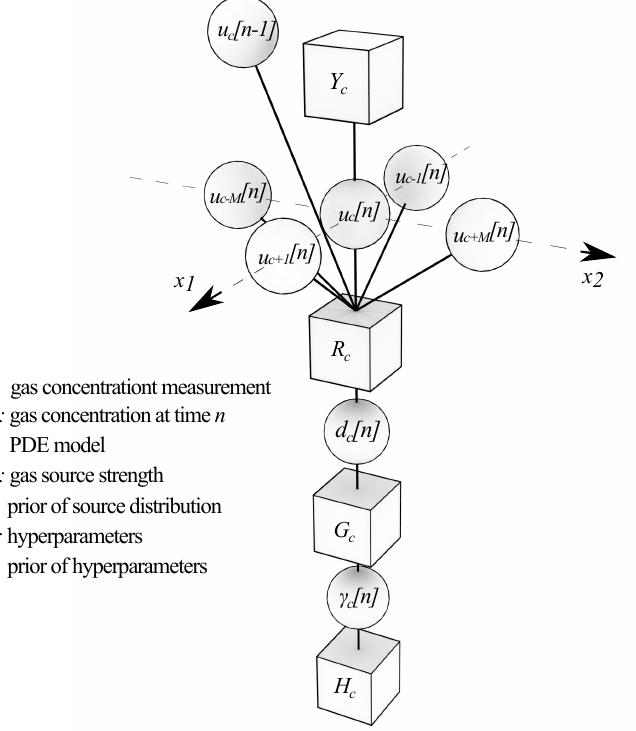
Figure 6. Factor graph representation of posterior pdf for one grid cell c in the spatial domain Ω under